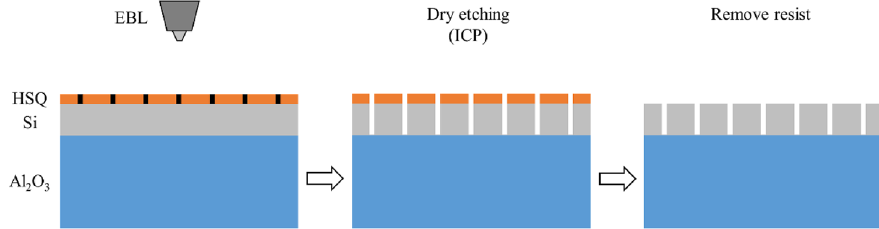
Fig. 9 Fabrication flow of the